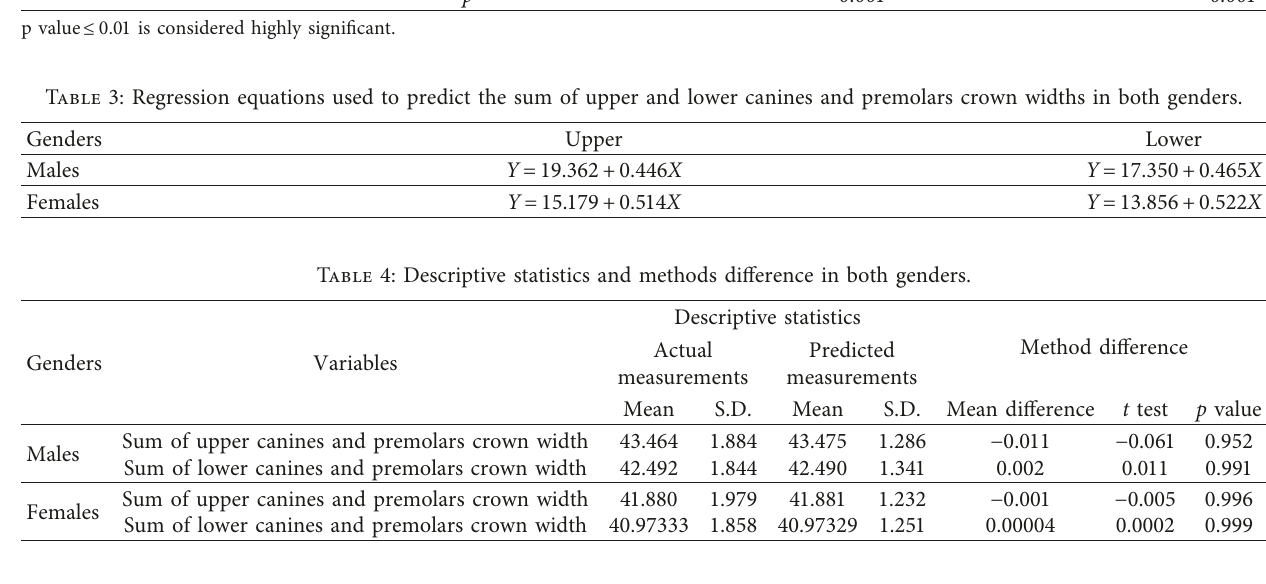
Table 5: The numbers and percentages of cases that lie within the limit of 2mm, over an underestimated actual combined width of canines and premolars in both arches and